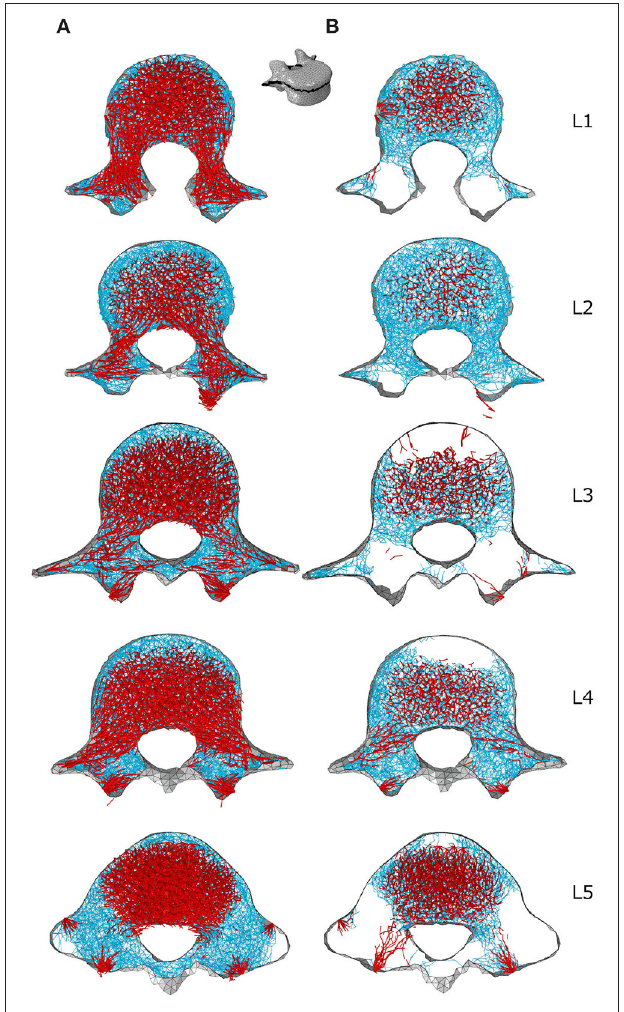
FIGURE 8 | Through-processes transverse (XZ plane) slices for the converged models adapted to the healthy scenario (A) and the sedentary scenario (B) . In the background, cortical shell elements are shown in grey. Thicker truss elements representing the primary structure located between the superior endplate and the through-processes transverse slice are shown in red. Trabecular truss elements representing the secondary structure (with a radius of 0.1 mm ) are shown in blue for a 3 mm slice. Truss elements in the dead zone (with a radius of 1 µ m ) are not shown for clarity.